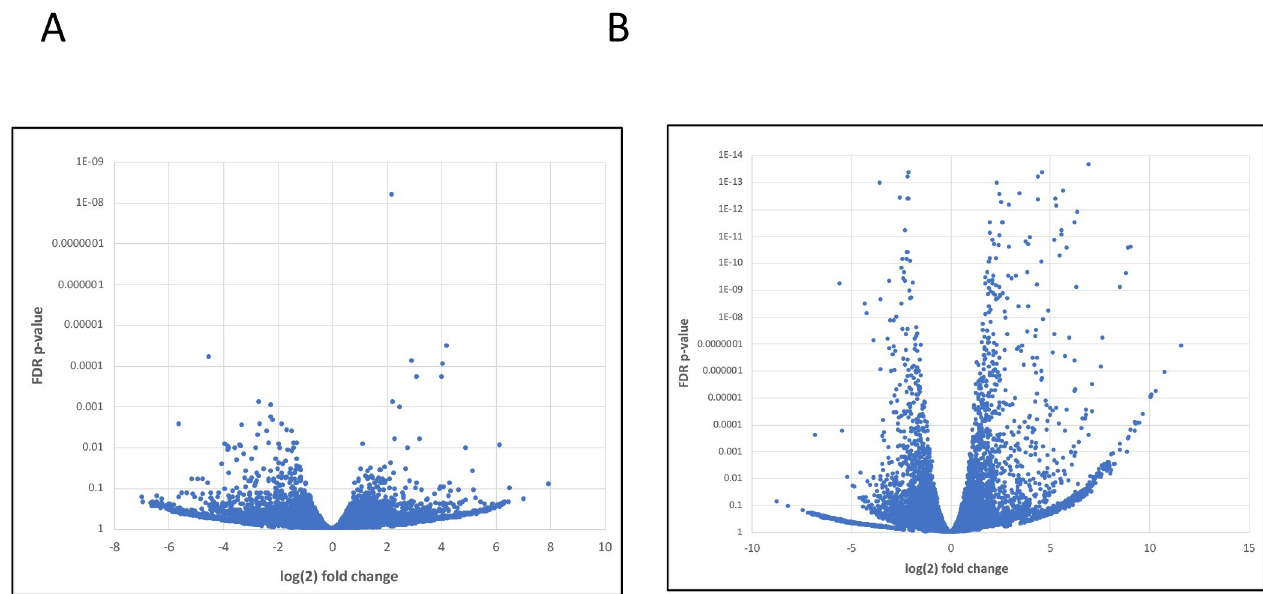
Fig 7. Volcano plots showing the extent of differential host gene expression in infected and AN3661-treated cells. A. Comparison of host cell gene expression in untreated and AN3661-treated cells. B. Comparison of host cell gene expression in uninfected and S . neurona -infected cells.